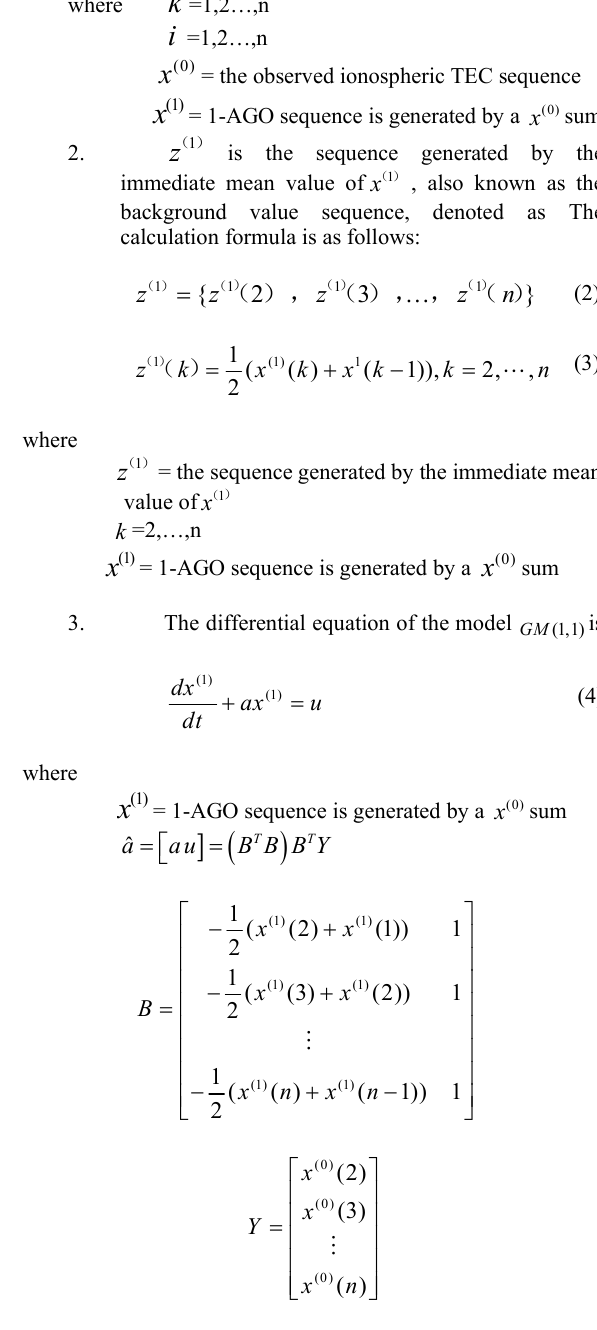
5. calculate the prediction residual of the model and generate the residual sequence, denote as